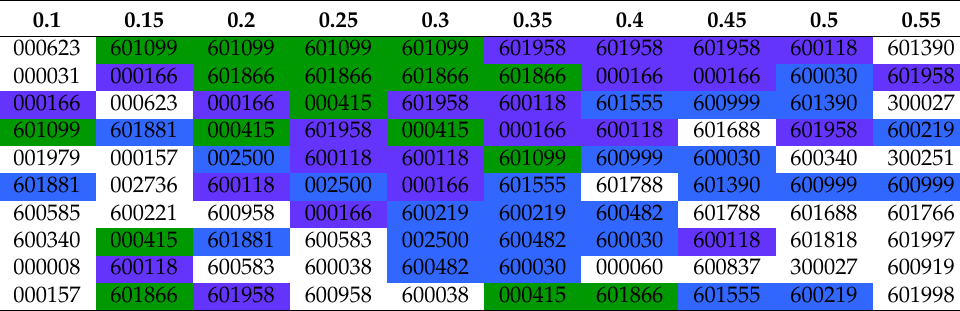
Figure 5. The network global attributes’ map with the thresholds. ( A ) shows the results of the proposed method. ( B ) shows the results of the stock price index correlation threshold method [21] (traditional method). The purple, blue, green and orange curves in the graph represent network density, efficiency, clustering coefficient and the fraction of the coverage of the network, respectively. Table 1. Degree centrality in the image similarity stock network.